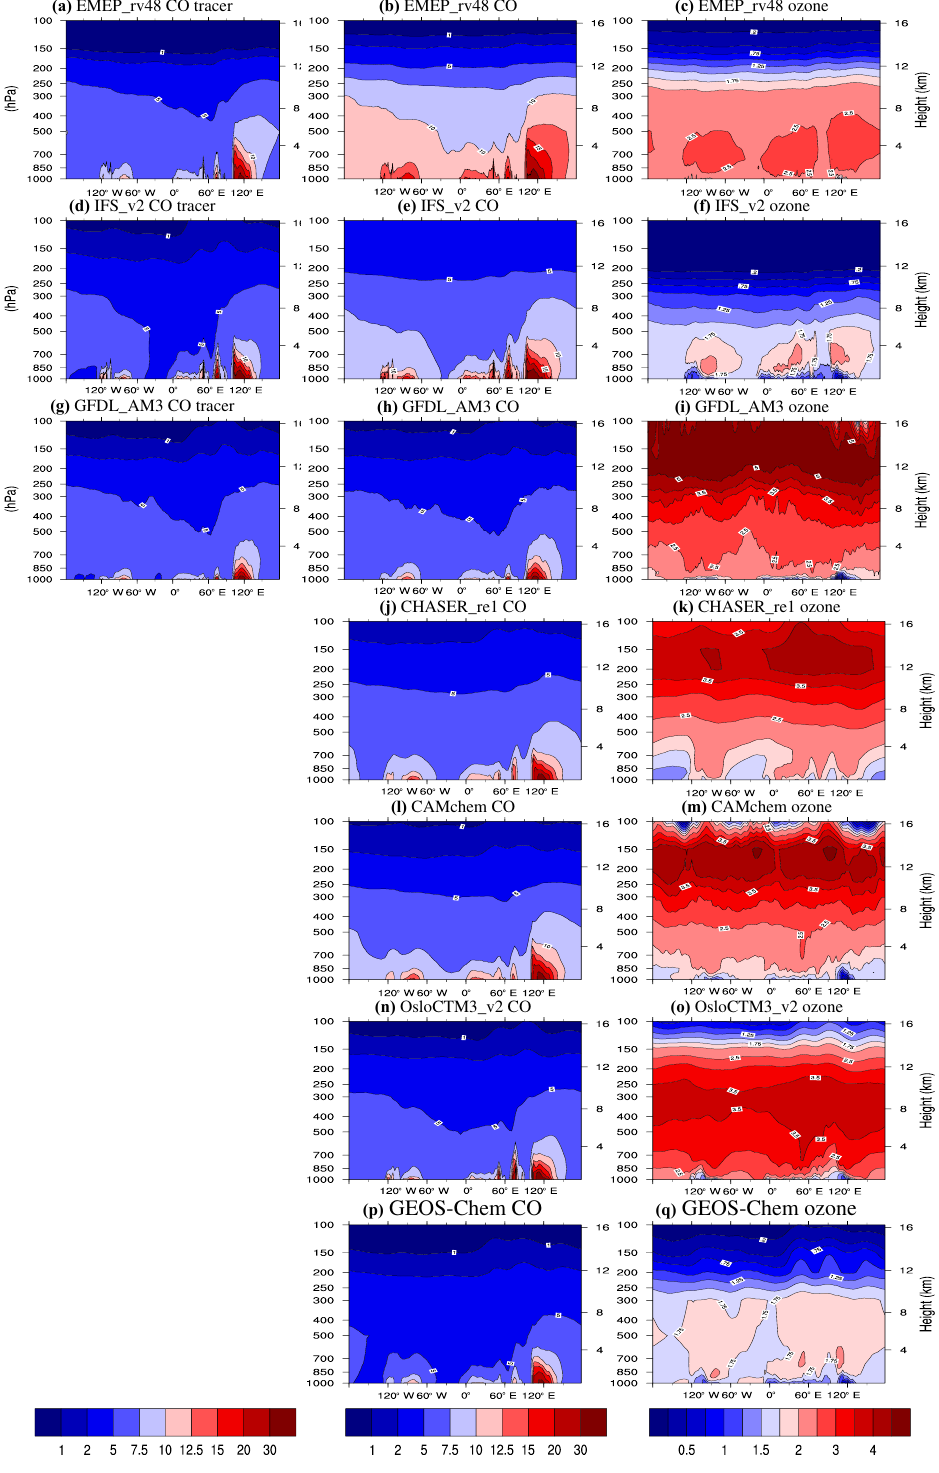
Figure 3. Annual contributions from the 20% (BASE–GLOALL) perturbations of the anthropogenic emissions to CO50 tracer (a, d, g) , CO (b, e, h) and O 3 (c, e, f) in ppb zonally averaged between 30 and 60 ◦ N. The models have been interpolated to a common vertical